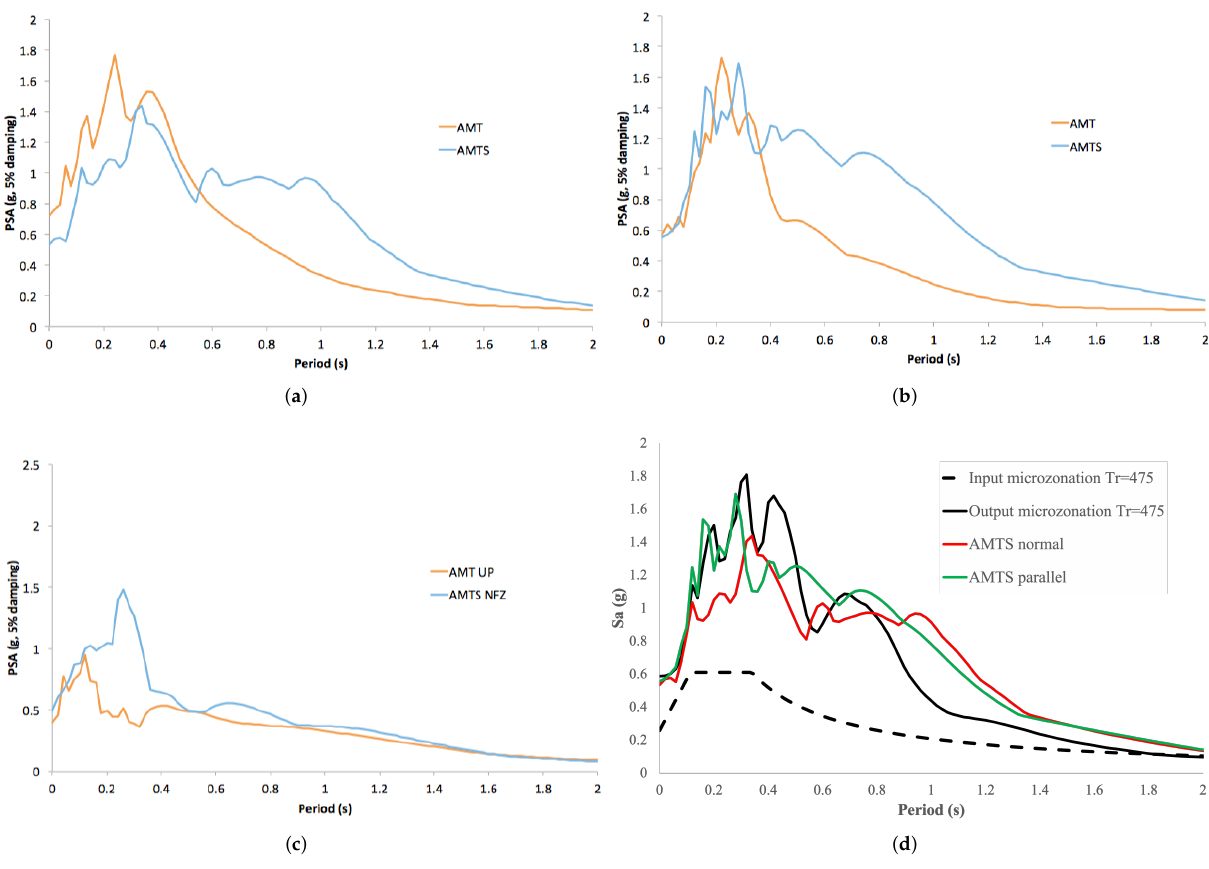
Figure 8. ( a ) The 5% damping acceleration response spectra measured by the OSS station (AMTS, blue curve) and by the RAN station (AMT, orange curve), with components projected in direction orthogonal to the fault; ( b ) like ( a ) but the components are projected in direction parallel to the fault; ( c ) like ( a , b ) but the vertical components are plotted; ( d ) comparison of AMTS response spectra with the results of the microzonation